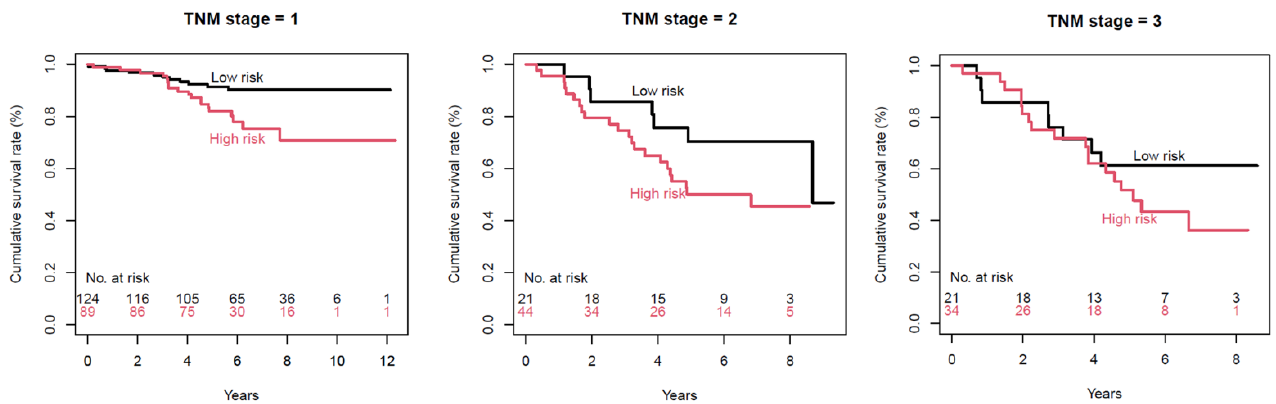
Figure 3. Kaplan–Meier survival curves by TNM stage, using radiomic margin characteristics. p -values for low-risk (black) versus high-risk (red) are 0.01, 0.1, and 0.3 for TNM stages 1, 2, and 3, respectively.